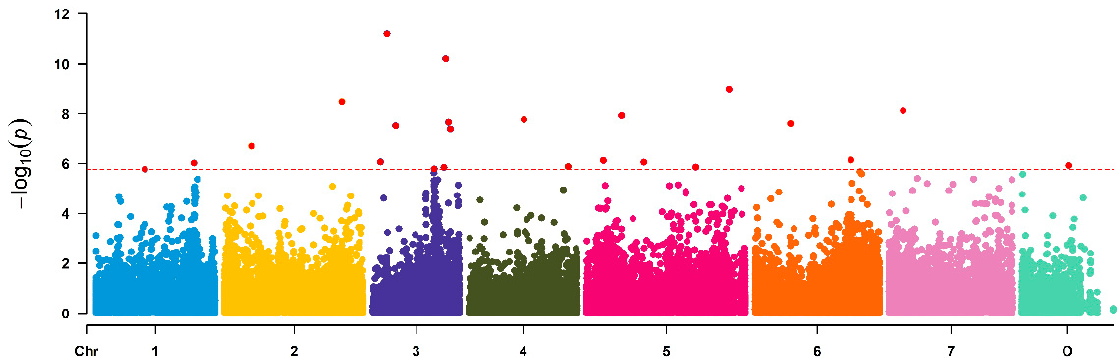
Figure 2. Manhattan plot of associations between 63,000 SNP markers and petal number in a set of 95 garden roses. For a better view of the clusters, the y -axis was scaled only to 1 × 10 − 12 . Supplementary Figure S2 displays the full Manhattan plot including the outlier markers. The x -axis represents the chromosomes of Rosa chinensis , including chromosome 0 with contigs not assigned to a precise location to date. Associations were calculated in Tassel 3.0 using MLM including population structure (Q), kinship (K) and Box-Cox transformed data of fragrance. The red dotted line indicates the Bonferroni corrected level of significance (-log10 = 5.75).